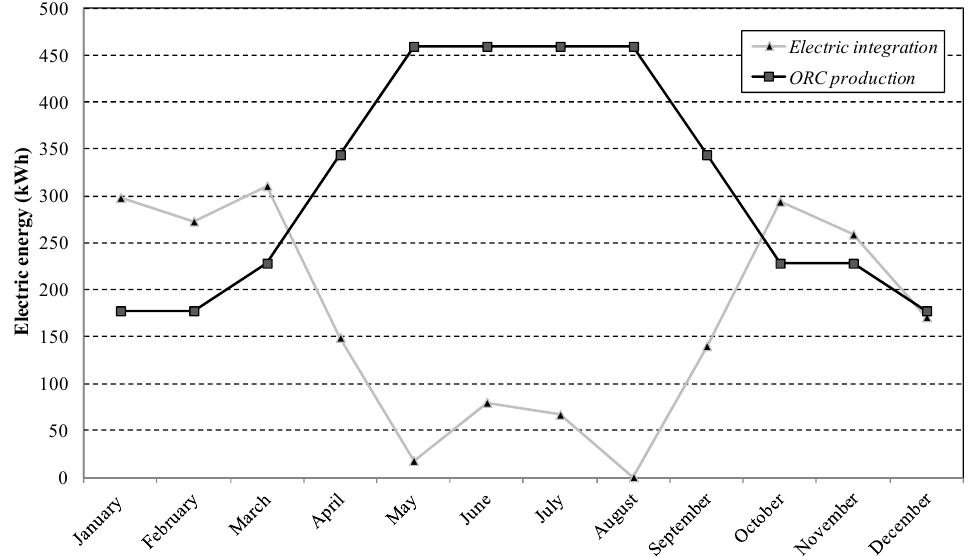
Figure 11. Electrical integration required by the CPV / T system and monthly electrical production of the ORC system.